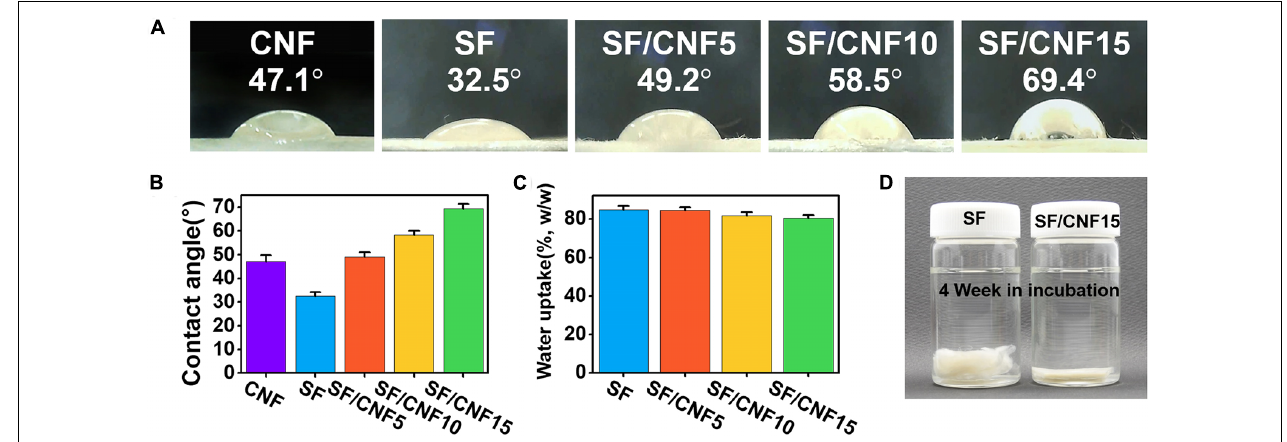
FIGURE 8 | (A,B) Initial water contact angles of the SF/CNF composites with various amounts of CNFs, (C) water uptake of SF/CNF composites with various amounts of CNFs after 24 h, and (D) nonwoven SF and SF/CNF15 composite after 4 weeks of